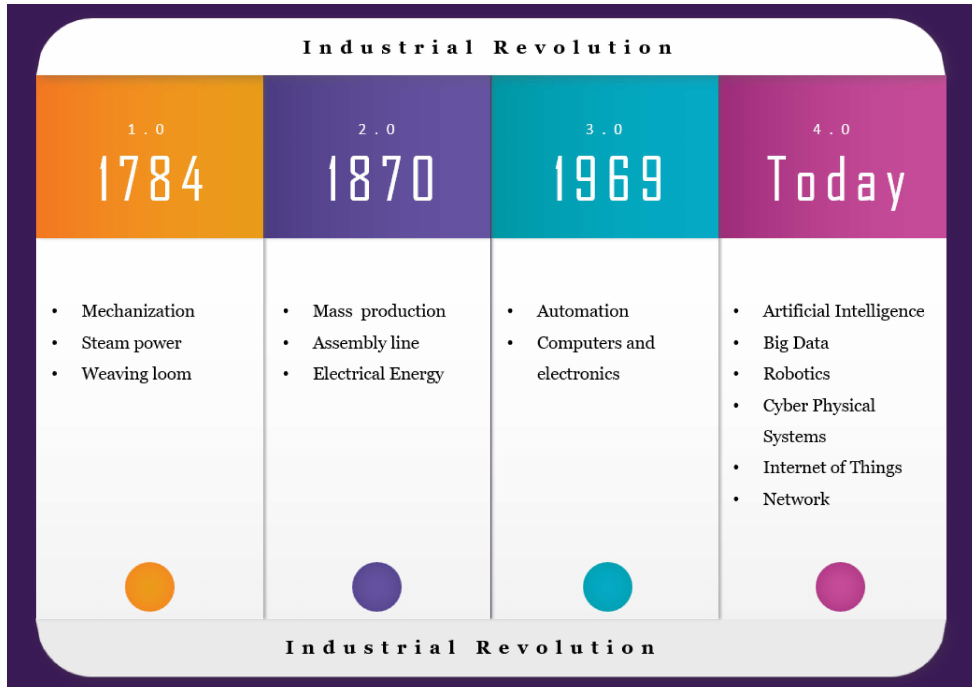
Figure 1. Industrial revolutions (from Industry 1.0 to Industry 4.0) and their